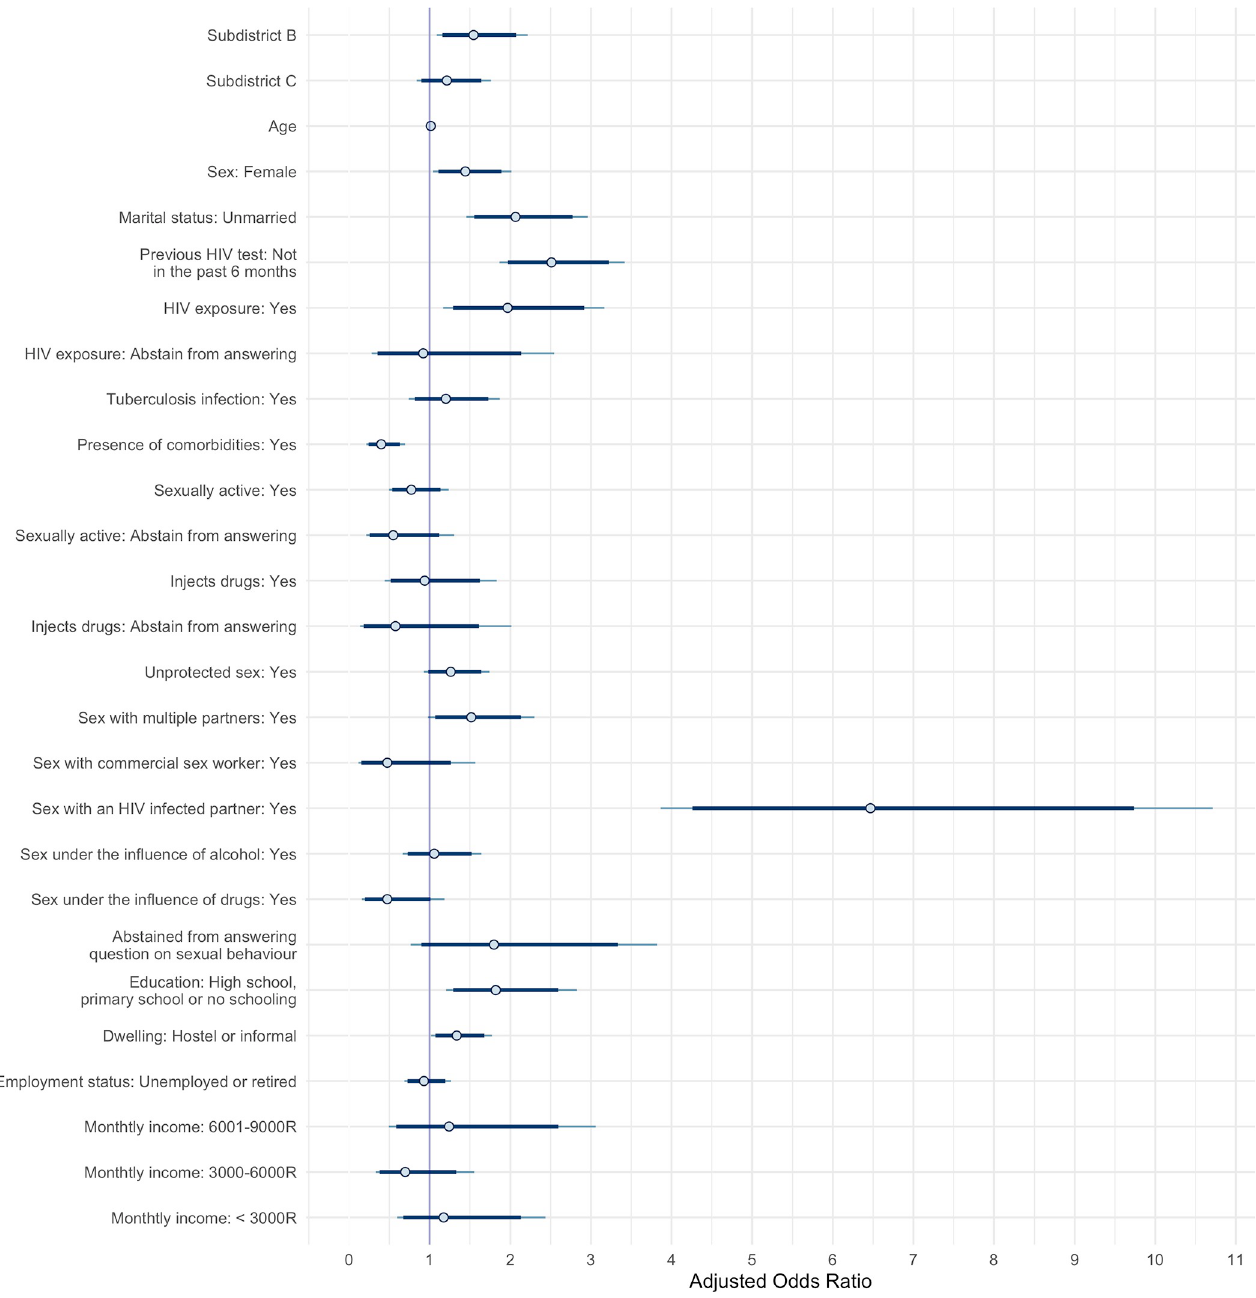
Fig 1. Bayesian logistic regression model posterior intervals of adjusted odds ratios of HIV infection. Points represent the posterior medians, thick segments represent the 89% credible intervals and thin segments represent the 95% intervals of the adjusted odds ratios.